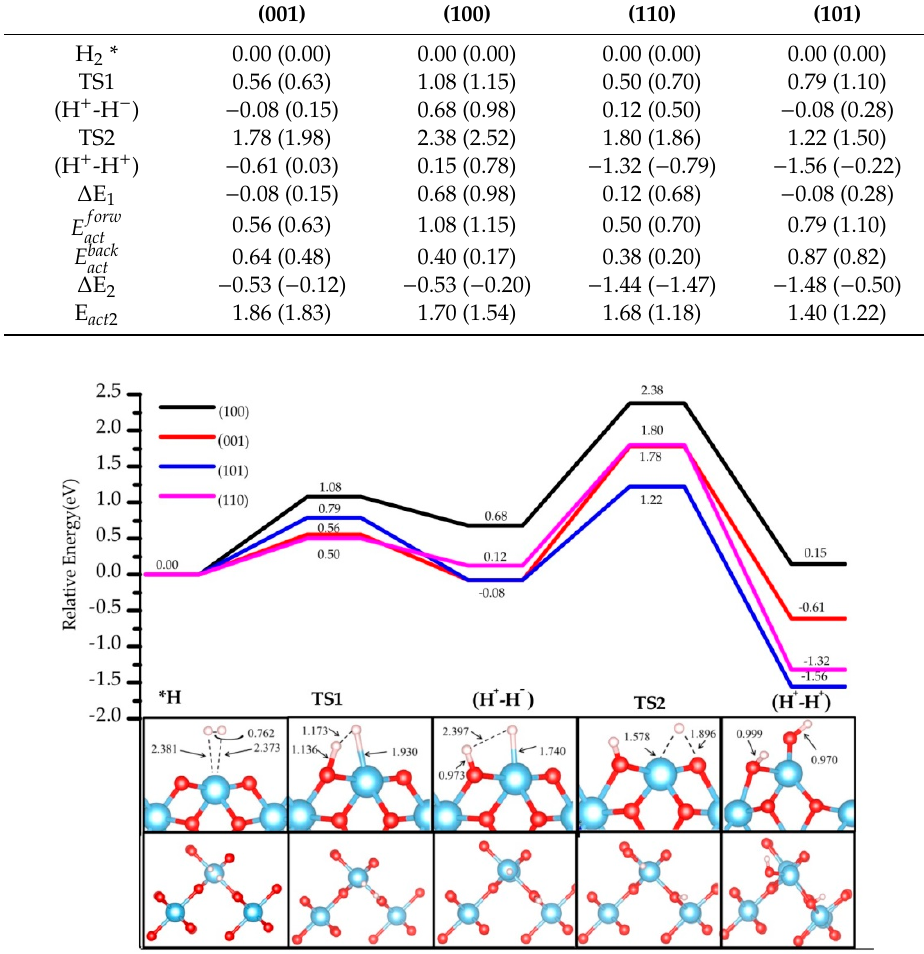
Figure 3. The energy profile of hydrogen dissociation and H transfer from Ti to near O on four rutile TiO 2 surfaces, namely (001), (100), (101), and (110). Inset images show the pathway (side view and top view) on TiO 2 (001); the three other pathways are depicted in Supplementary Figures S1–S3. The bond distance is in Å.